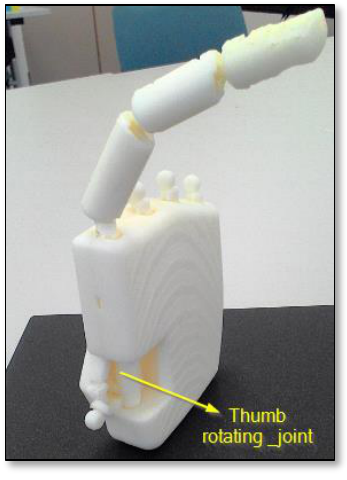
Figure 8. – Hand assembly